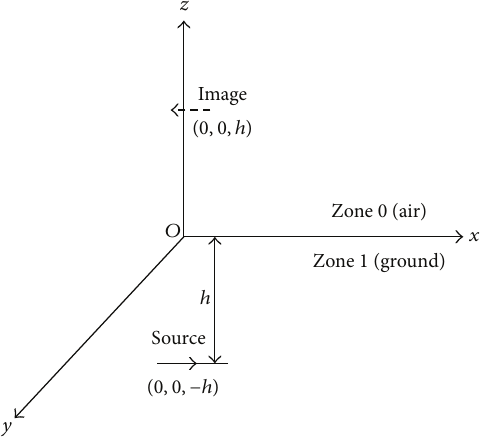
Figure 1: Schematic of the horizontal electric